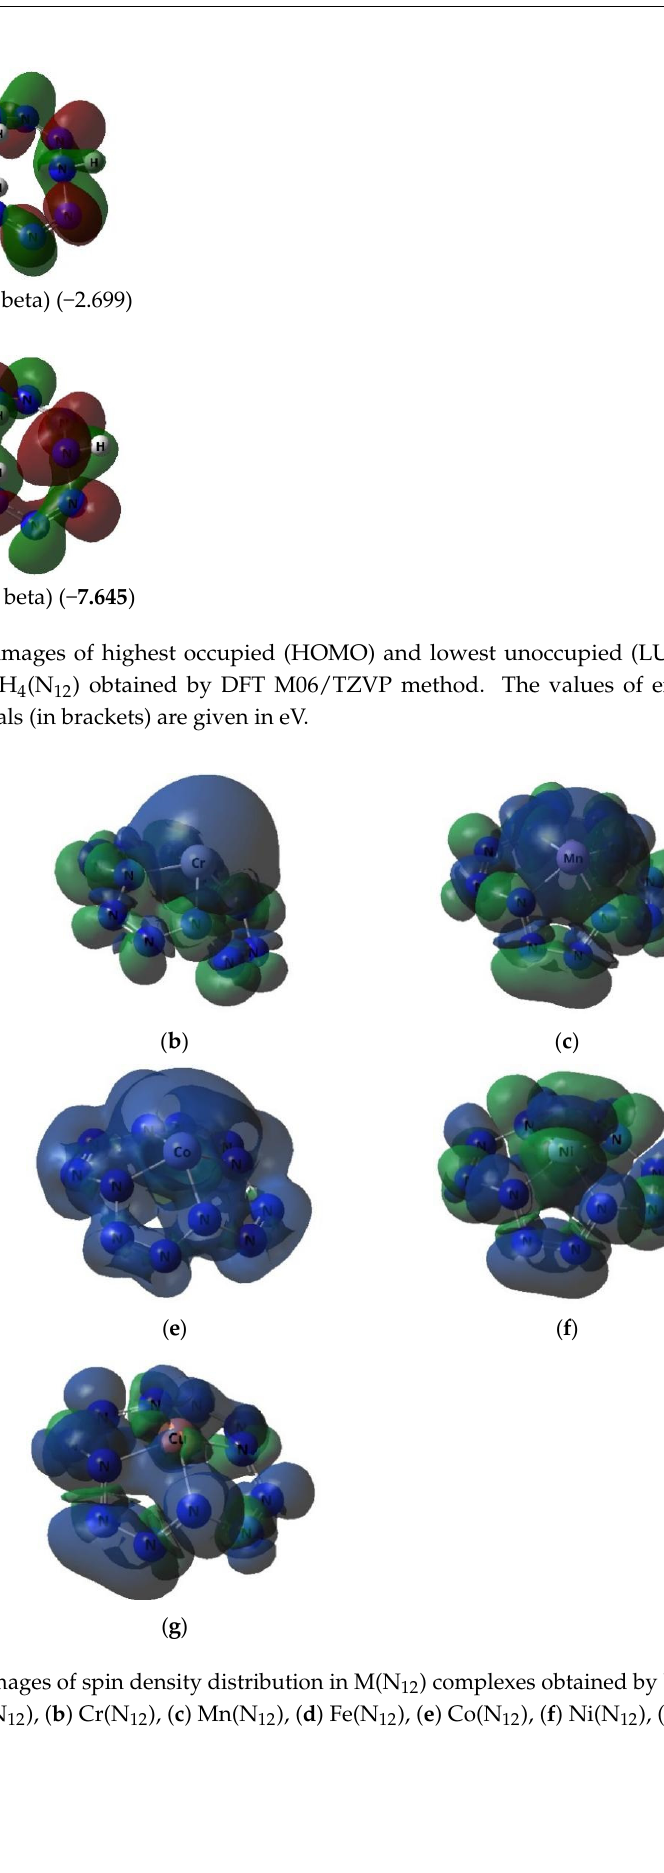
Figure 3. The images of highest occupied (HOMO) and lowest unoccupied (LUMO) molecular or- bitals in the M(N 12 )] complex of group B obtained by DFT M06/TZVP method. The values of energies of these molecular orbitals (in brackets) are given in eV. The symbol “alpha” corresponds to electron with spin (+1/2), “beta”, to electron with spin ( − l/2).